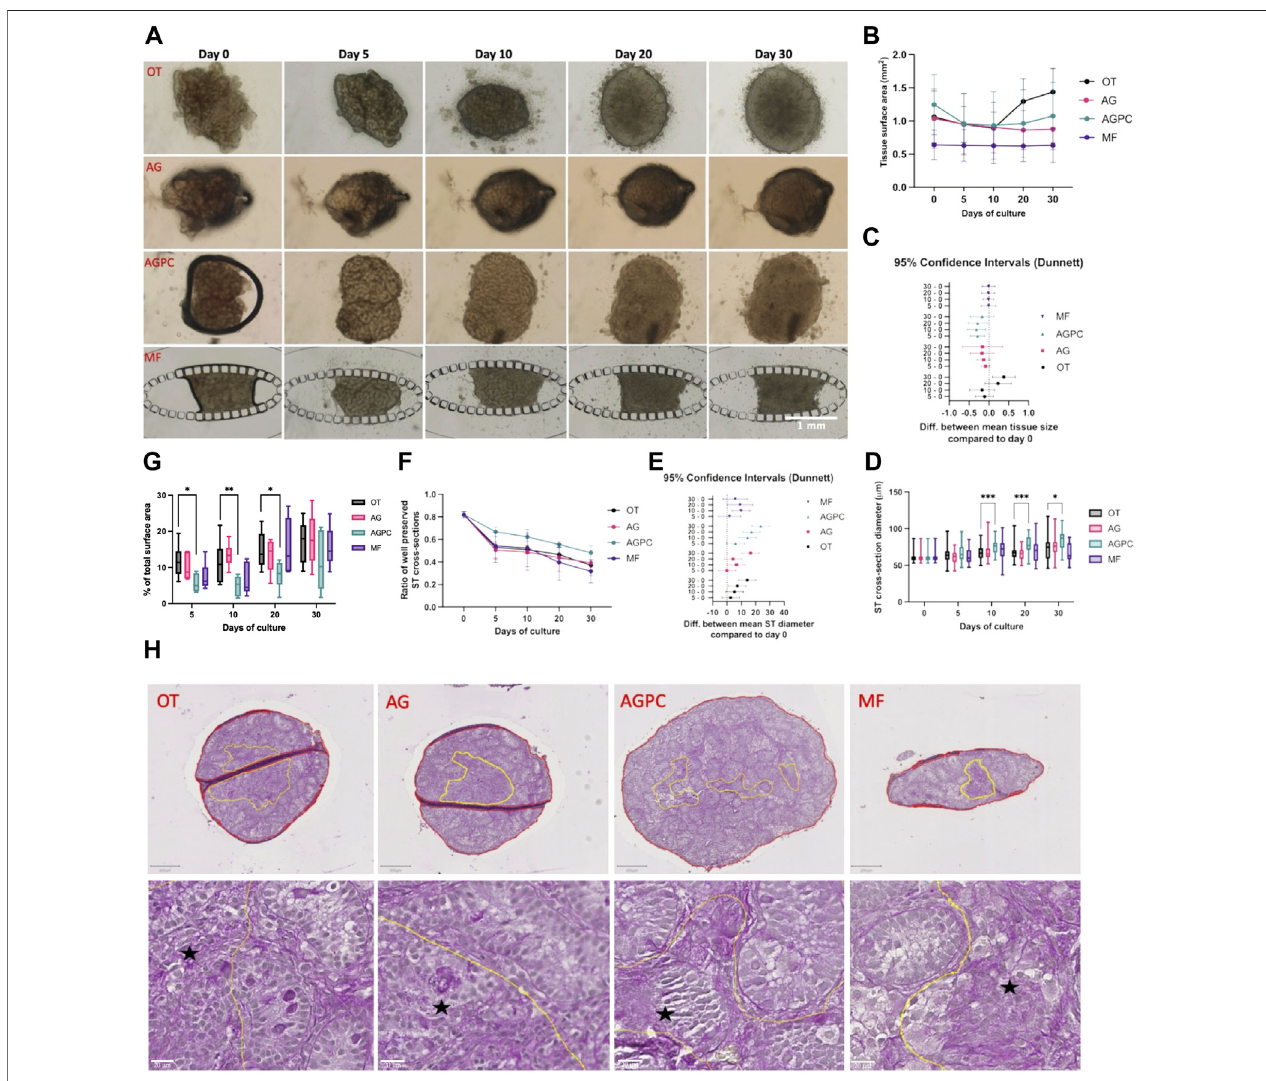
FIGURE2| Evolutionoftissuesizechange,STcross-sectiondiameterandintegrity,andtissuecoredegenerationoverthecultureperiod. (A) Photographicimages oftissuefragmentsinthedifferentsystemsfromday0today30. (B) Evolutionofmeantissuesizeovertimeinallsystems. (C) Differenceinmeantissuesizebetweenday 30,20,10andday0. (D) EvolutionofmeanSTcross-sectionsdiameterinthedifferentsystemsoverthecultureperiod. (E) DifferenceinmeanSTcross-sectiondiameter betweenday30,20,10andday0. (F) EvolutionofmeanSTcross-sectionsintegrityinthedifferentsystemsoverthecultureperiod. (G) Changeinthepercentageof the central degenerative area(among totaltissue area)inthe differentsystems overtheculture period. (H) Assessementoftheintegrityofthetissue coreonPASstained slides at day 30. Yellow lines: zone(s) with poor core integrity. Red line(s): total tissue surface area. Black star: areas with altered tissue architecture. OT, culture insert PTFE; AG, Agarose; AGPC, Agarose + PDMS cover, MF, Micro fl uidic.